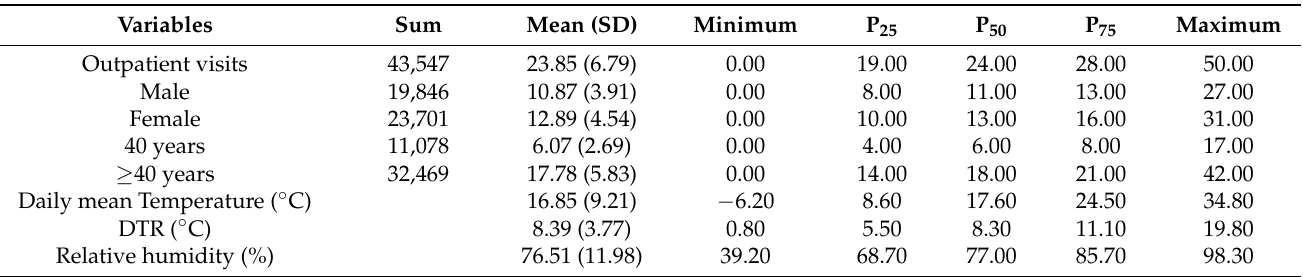
Table 1. Summary statistics of outpatient visits for HZ and meteorological variables in Hefei, China, during the period